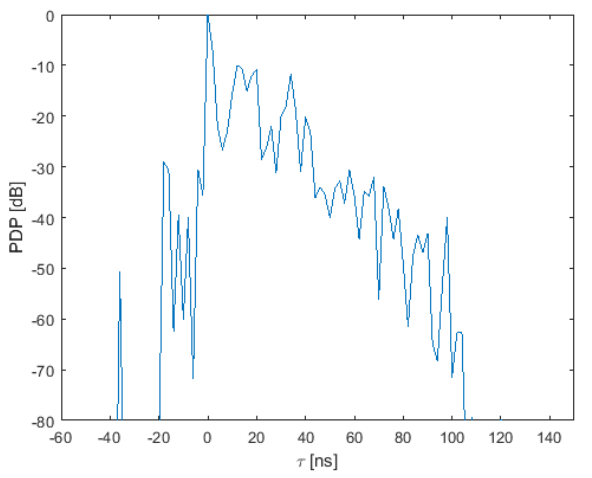
Figure 12. APDP inside the laboratory.